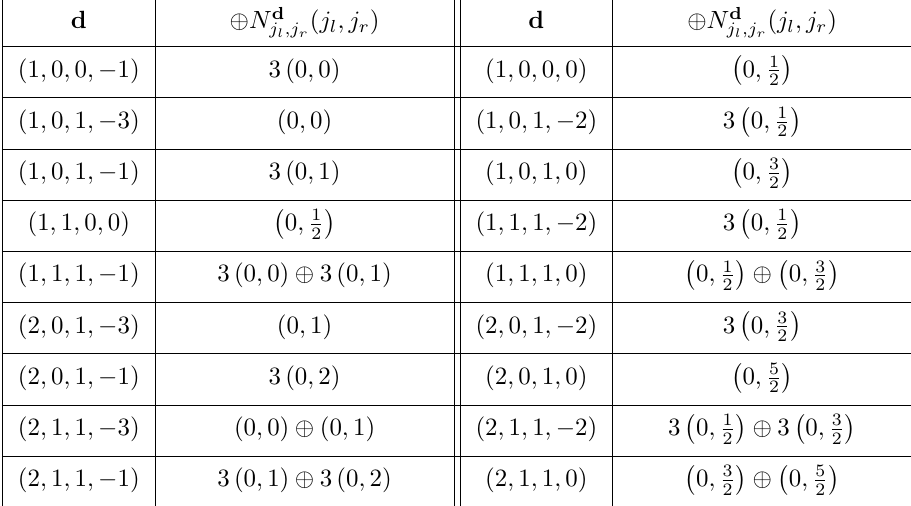
Table 15. BPS spectrum of Sp(2) + 3 Λ 2 for d 1 ≤ 2 , d 2 ≤ 1 , d 3 ≤ 1 . Here, d = ( d 1 , d 2 , d 3 , d 4 ) labels the BPS states with charge d 1 e 2 + d 2 f 1 + d 3 f 2 + d 4 x i and d 4 counts collective degrees of all anti-symmetric